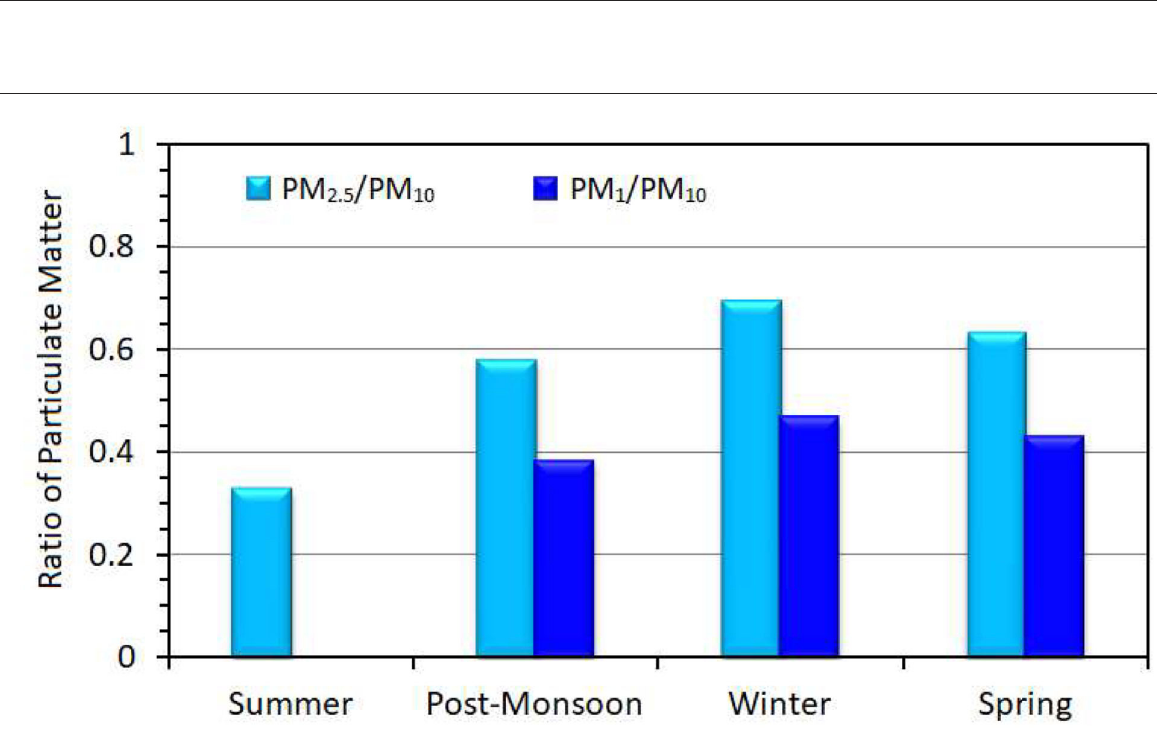
FIGURE5 Seasonal variation in the ratio of particulate matters (PM 1 , PM 2.5 with PM 10 ) from April 2019 to March 2020 over